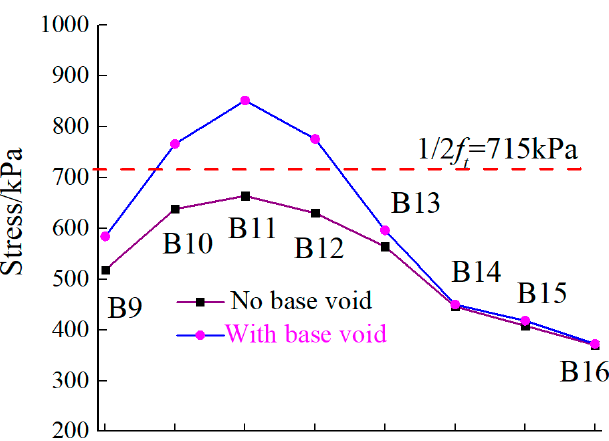
Figure 17. Relationship between peak stress and allowable stress at the measuring points of the invert.